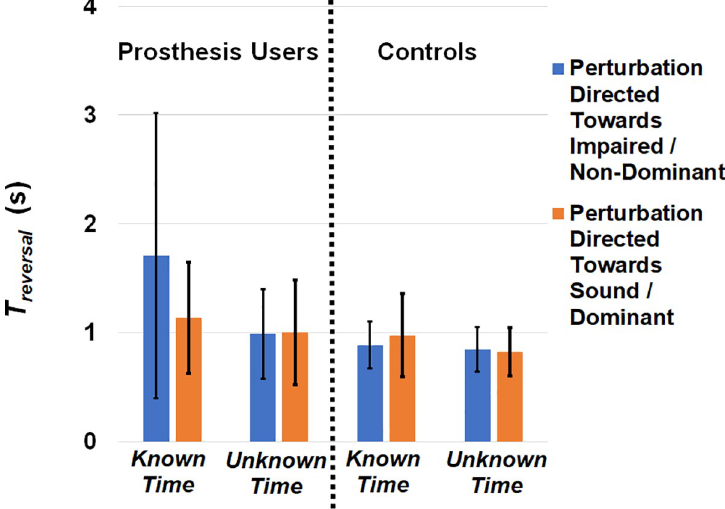
Fig 5. Average time to reversal ( T reversal ) separated by group, perturbation direction, and perturbation timing knowledge. The main effect of timing knowledge was significant (p = 0.043), with a greater T timing was known. Error bars denote 95% confidence